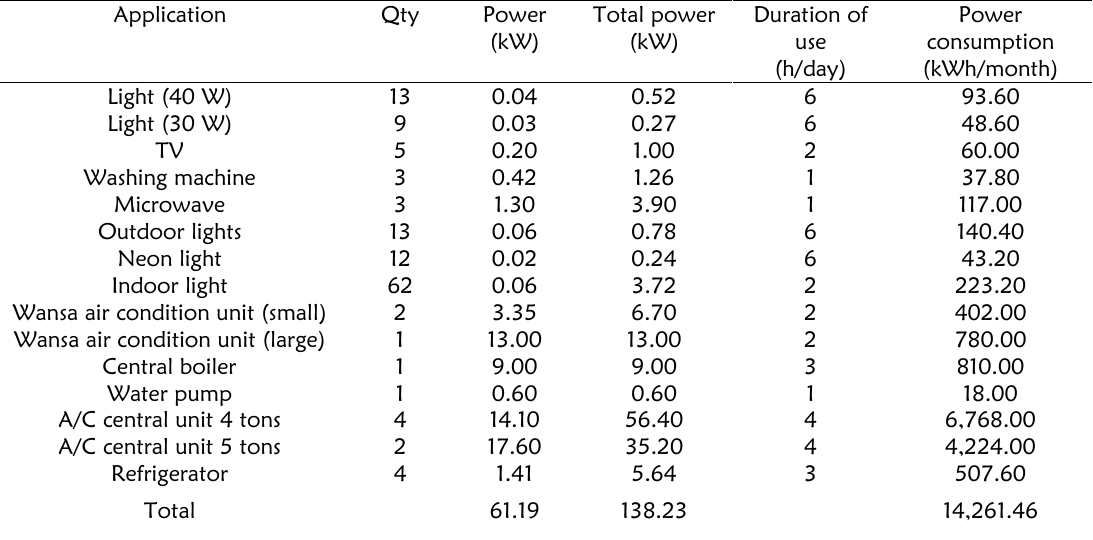
Table 2: Electrical usage in Kuwait